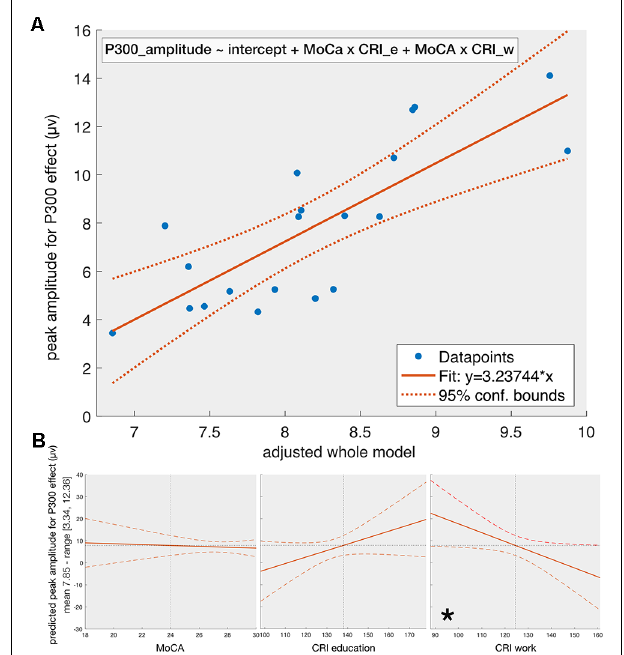
FIGURE 2 | The fit of the whole model on P300-amplitude (Panel A ) and the effect of individual predictors (Panel B ) given that the other predictors are constant. Panel (A) shows the dependency of the amplitude of the P300-effect on the adjusted whole model (see equation 1) obtained from stepwise regression with MoCA, CRI_e, CRI_w, and CRI_l, and their first level interactions as predictors. The final model contains the MoCA*CRI_e and MoCA*CRI_w as predictors. The solid line represents the fit of the obtained model and the dotted lines reflect the 95% confidence intervals. Panel (B) reflects the effect of individual predictors included in the final obtained model on the peak amplitude of P300-effect given that the other predictors are constant. When all other predictors are kept constant, the only significant one is the CRI_w. This is because the predictors of the obtained model are interactions of the initial factors and the p -value for removal of predictors during the stepwise regression was set by default to 0.1 (see the section on statistics), which is higher than the p -value we set for statistical significance (0.05). CRI_e—the education score for CRI, CRI_w—the working attainment score for CRI, *indicating a significant relationship if the other predictors are kept